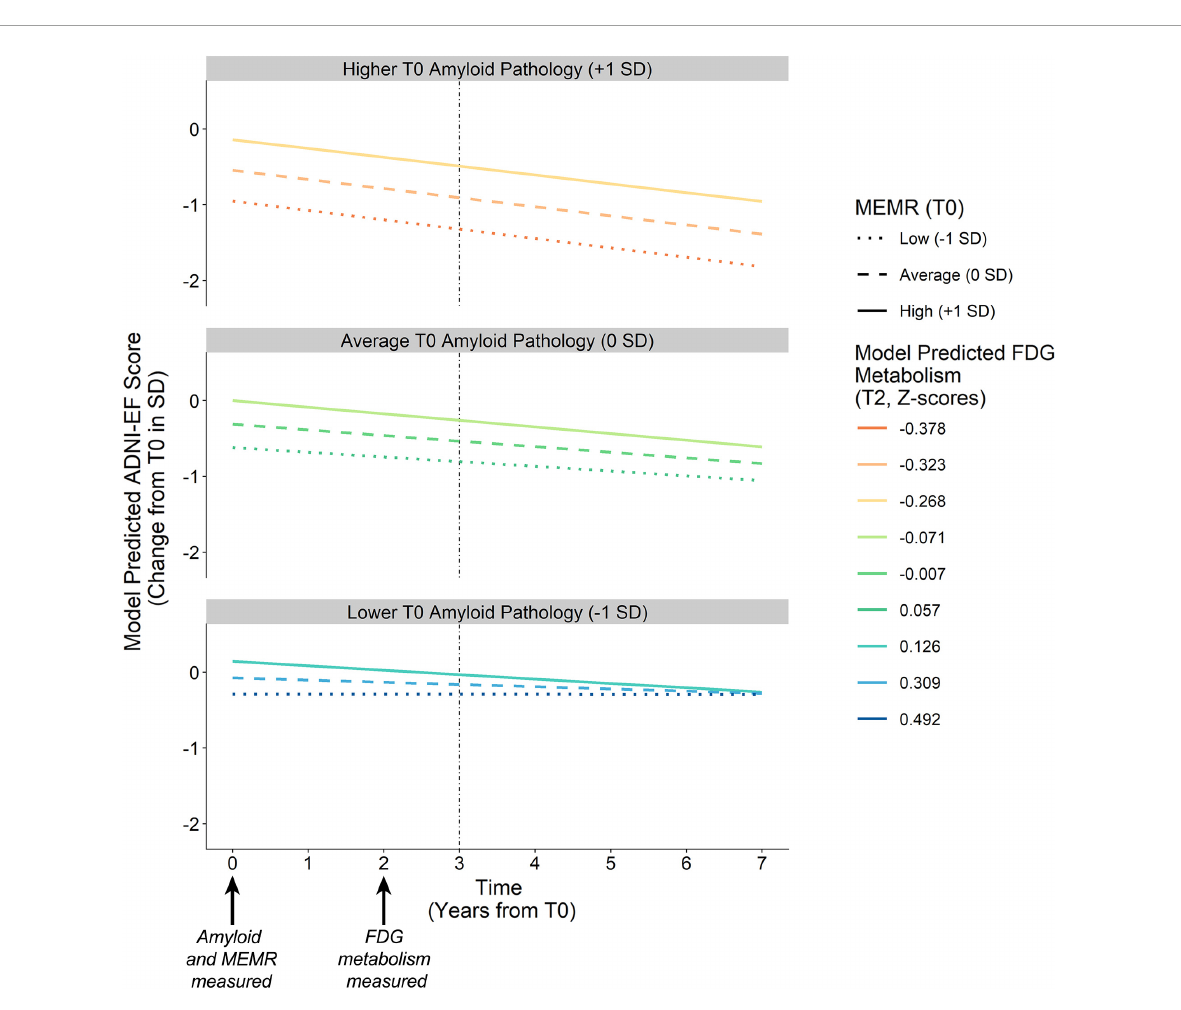
FIGURE5 Model-predicted ADNI-EF intercept and slope derived from conditional B AN indirect effects. Amyloid pathology (T0) is defined by continuous variable A β 42 /A β 40 , which is separated into higher pathology (–1 SD), average pathology (0 SD), and lower pathology (+1 SD) for illustration purposes. Colored lines represent the downstream neurodegeneration (i.e., FDG metabolism) predicted by the interaction between amyloid pathology A β 42 /A β 40 and the residual reserve index (MEMR) at T0. Solid vs. dashed lines denote the chosen levels of MEMR. The vertical dashed line denotes the ADNI-EF intercept, modeled to succeed measurement of the antecedent biomarkers. B AN , the amyloid eneurodegeneration → ADNI-EF indirect effect; FDG, uptake of 18 F fluorodeoxyglucose tracer in AD-specific regions of interest; MEMR, the residual reserve index; A β 42 /A β 40 , ratio of CSF β -amyloid 1 - 42 to β -amyloid 1 - 40